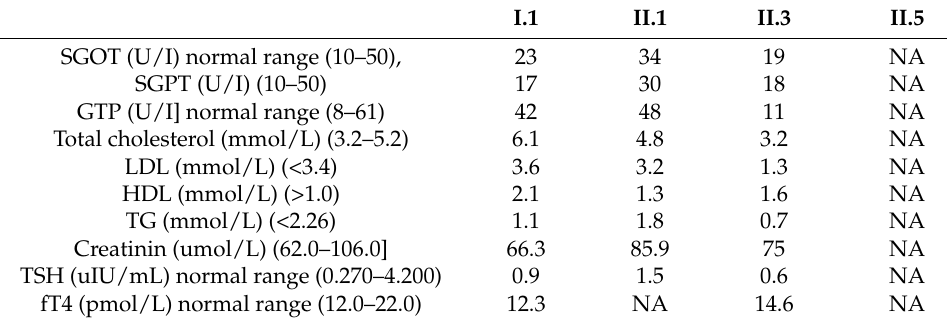
Table 3. Current biochemical status of affected